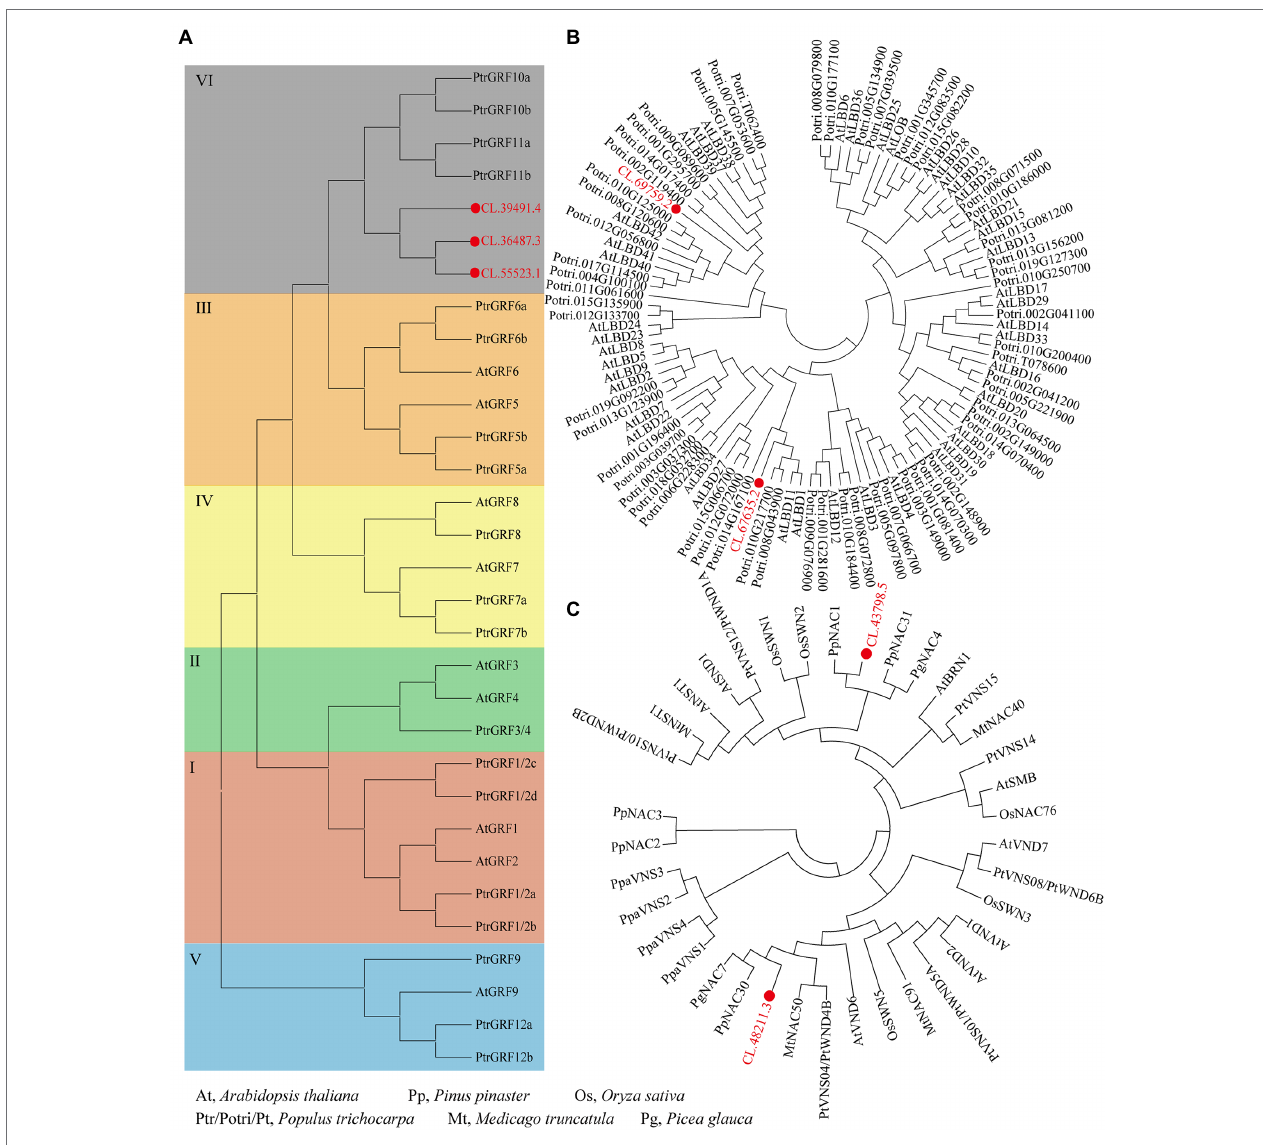
FIGURE 8 | Phylogenetic analyses of C. lanceolata GRF, LBD and NAC TFs with their homologs from other plants. (A) Phylogenetic analysis of C. lanceolata GRF TFs with homologs from Arabidopsis thaliana and Populus trichocarpa ; (B) phylogenetic analysis of C. lanceolata LBD TFs with homologs from A. thaliana and P. trichocarpa ; (C) phylogenetic analysis of C. lanceolata NAC TFs with homologs from five plant